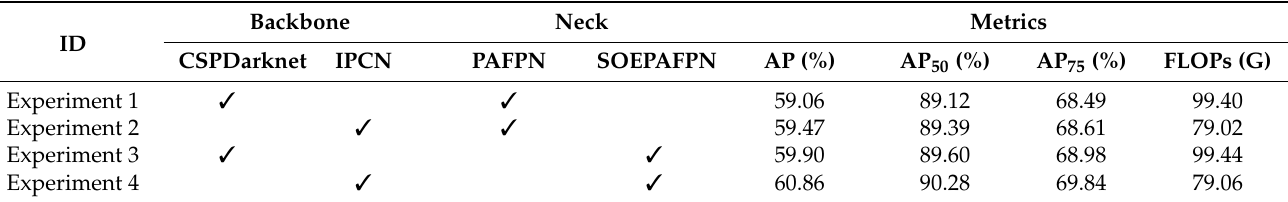
Table 2. Results of ablation experiments.